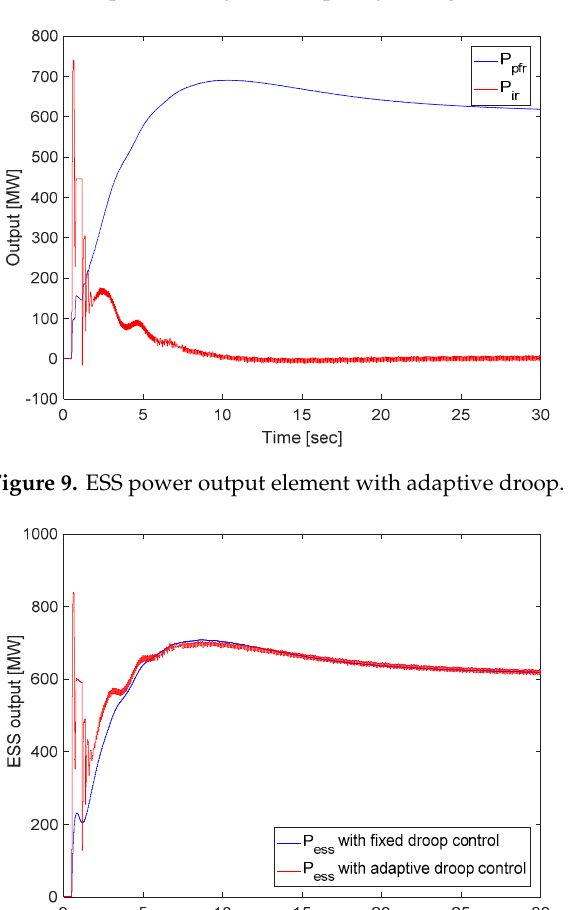
Figure 8. Comparison of system frequency with generator trip.